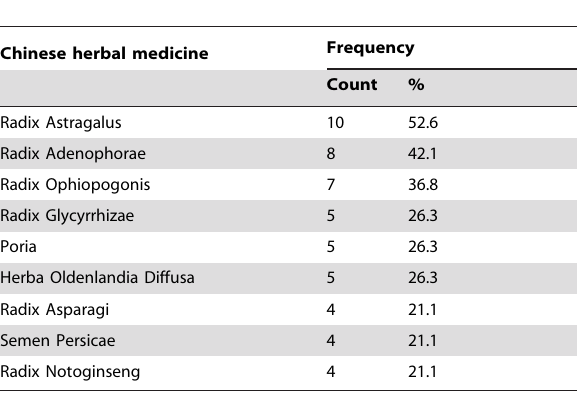
Table 2. Herbs frequently used for non-small cell lung cancer.